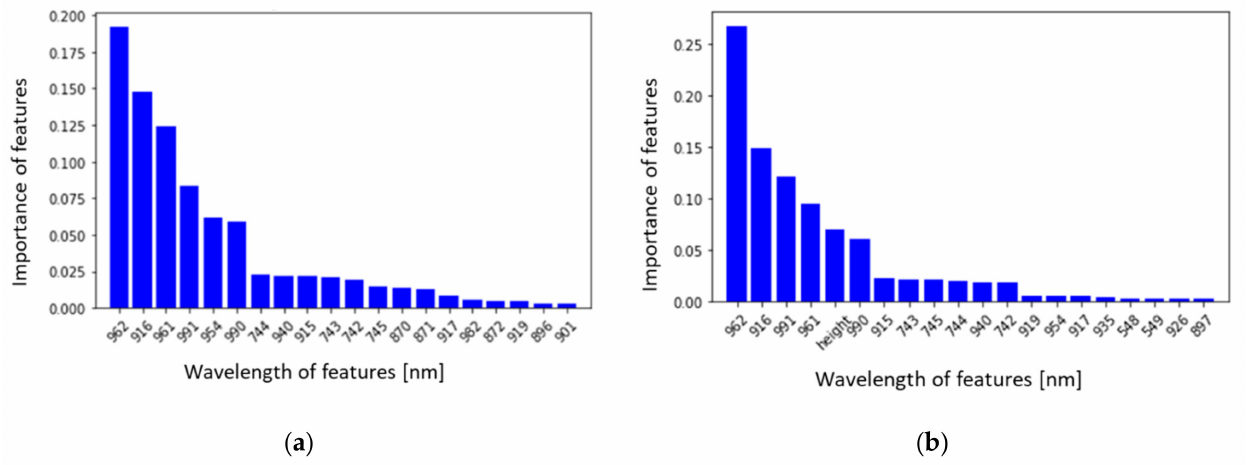
Figure 9. Importance of features of random forest regressor. ( a ) Trained to estimate DMY from hyper spectrum; ( b ) Trained to estimate DMY from the hyper spectrum with grass height. X-axis represents the wavelength of the feature (Unit: nm) or grass height (indicated as height), while the Y-axis represents the importance of